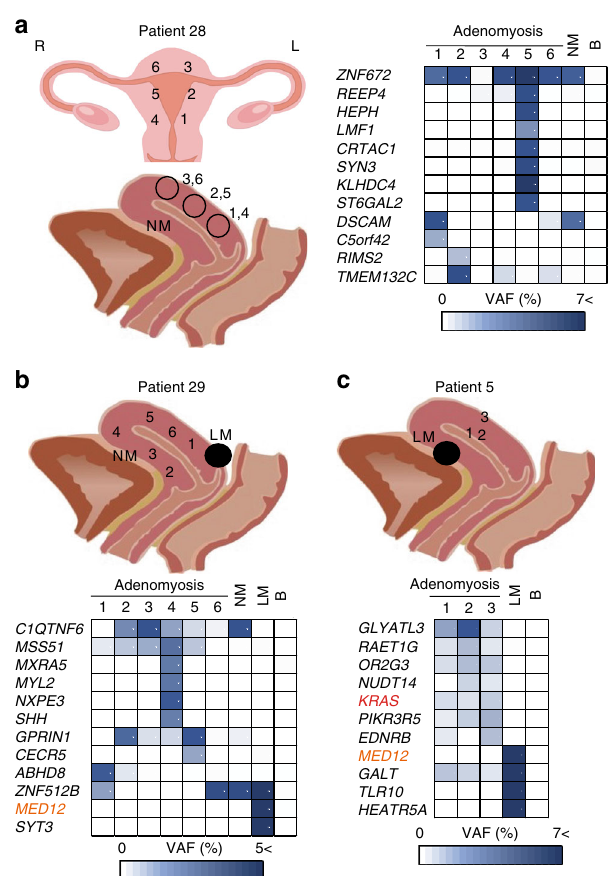
Fig. 3 Oligoclonality in adenomyosis tissues as revealed by multi- regional sampling. a Left panel: coronal plane (top) and sagittal plane (bottom) schemes indicating the sites of multi-regional adenomyosis samples (1 – 6) and adjacent histologically normal myometrium (NM) that were acquired from Patient #28 and subjected to mutational pro fi ling. R, right; L, left. Right panel: VAFs of mutations in the indicated genes in the indicated multi-regional samples pro fi led for each individual adenomyosis lesion, NM, or peripheral blood (B) sample from Patient #28. VAF values are shown using a color scale. b , c Top panels: sagittal plane schemes indicating the sites of multi-regional adenomyosis samples plus NM and leiomyoma (LM) samples that were acquired from Patient #29 ( b ) or Patient #5 ( c ) and subjected to mutational pro fi ling. Bottom panels: analysis of VAFs for the samples in the top panels as for a . For a – c , raw VAF values (%) for each sample are shown in Supplementary Data 14 –